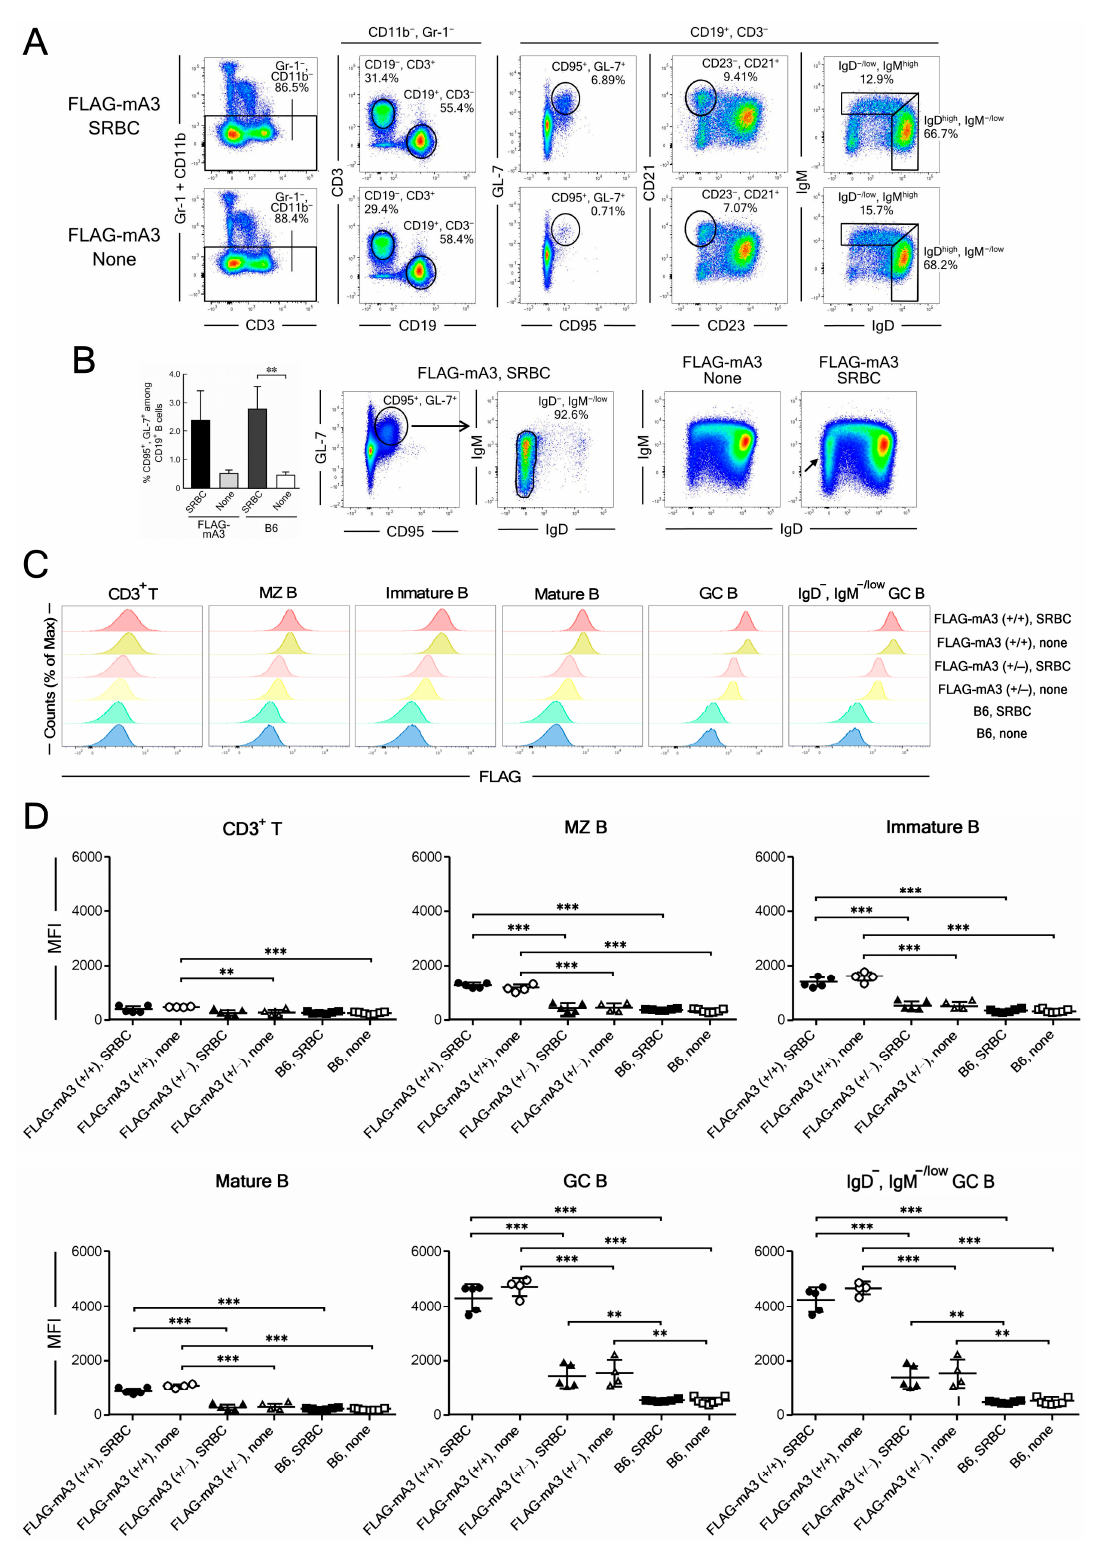
Figure 5. Flow cytometric analyses of intracytoplasmic mA3 expression in different subpopula- tions of spleen cells before and after immunization with SRBC in vivo. ( A ) Representative